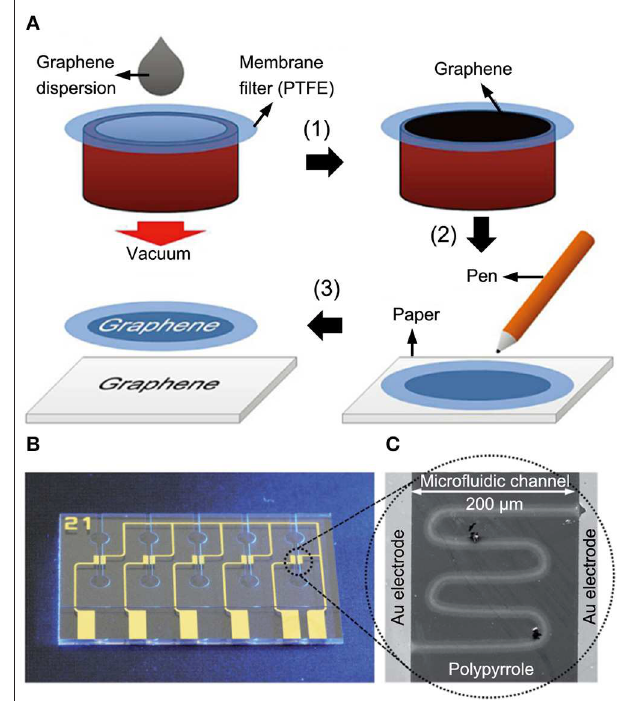
FIGURE 1 | Making graphene circuit on paper substrate via vacuum filtration method. The graphene dispersion is filtered by a PTFE membrane (A1) , and the membrane filter is turned over and put on a paper, and a circuit is drawn on the back of the membrane filter with a pen (A2) , and the membrane filter is removed from the paper substrate and the target is formed (A3) , and the image of a microfluidic chip is fabricated on a quartz glass wafer (B) , and scanning electron microscopy (SEM) image of polypyrrole pattern is written with a laser between the gold electrodes (C) . Reproduced with permissions from Hyun et al. (2013). Copyright 2013, Wiley-VCH. Reproduced with permissions from Agarwal et al. (2017). Copyright 2017, Royal Society of